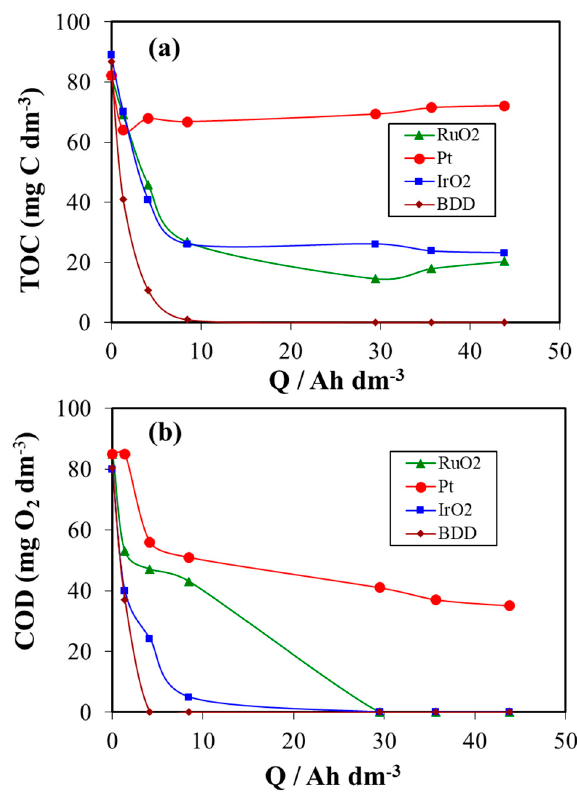
Figure 2. Oxidation and mineralization progress during the electrochemical treatment of urine wastewater at different electrodes.